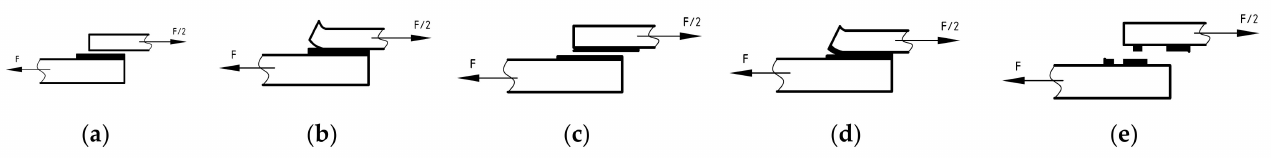
Figure 9. Failure forms of adhesive joints: ( a ) adhesive; ( b ) adhesive caused by peel stress;